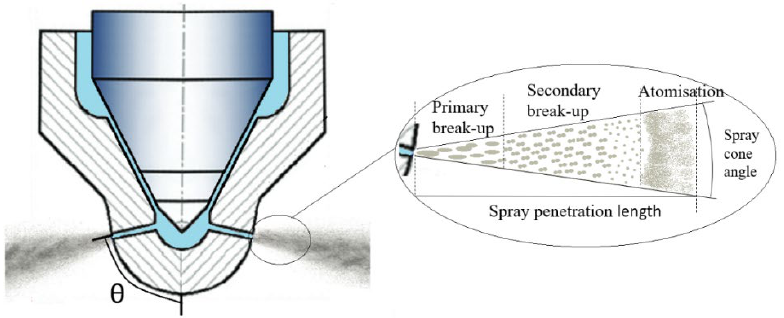
Figure 4. Spray characteristics at the nozzle exit.